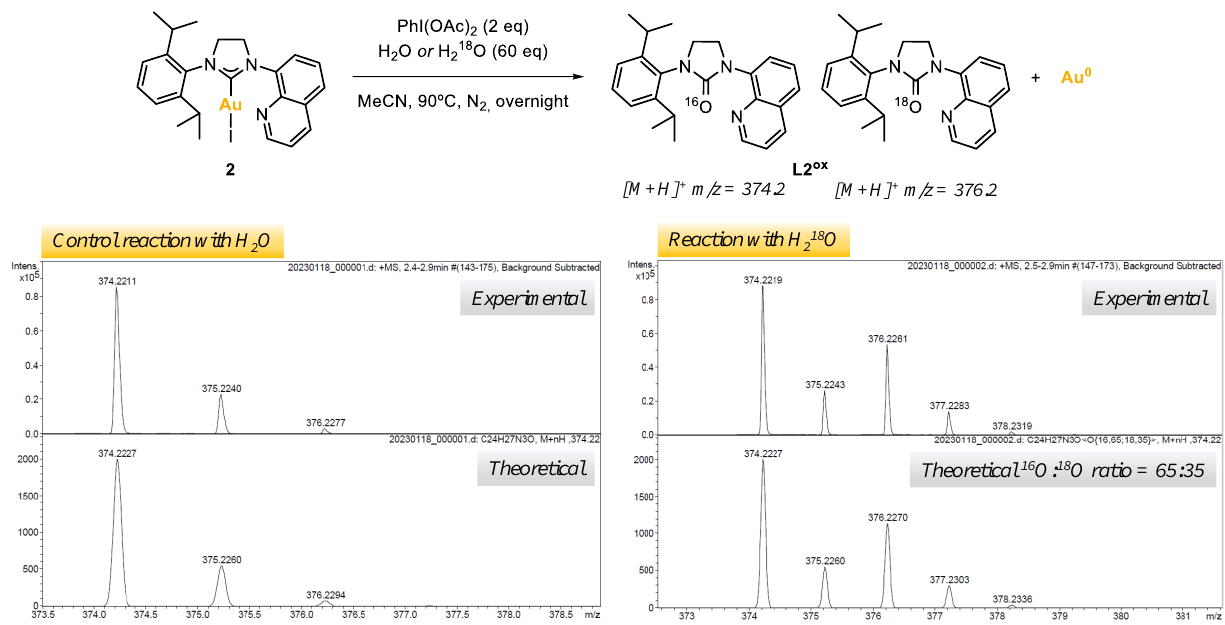
Figure 4. Reaction of complex 2 with PhI(OAc) 2 (2 eq) and water or 18 O-labeled water (60 eq), and peaks of L2 ox obtained by ESI-HRMS(+).